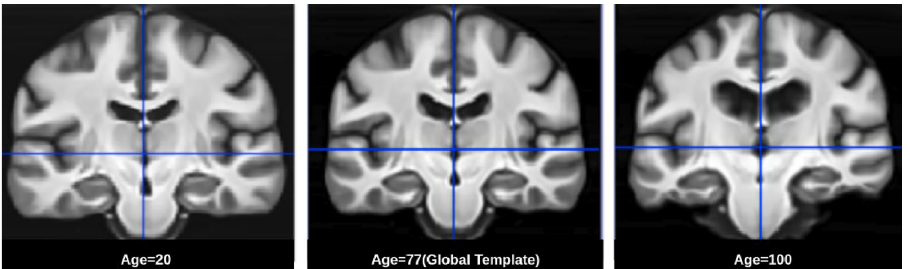
Figure 8. The central coronal slices of extrapolated age-templates are shown along with the global template image.